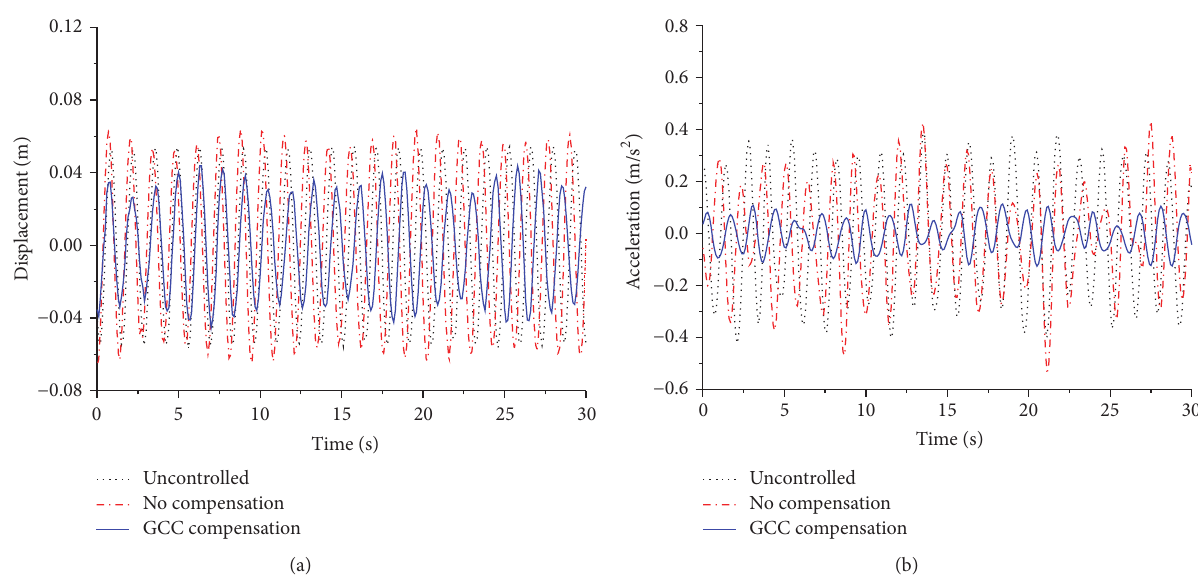
Figure 11: Comparison of structural responses to 4th floor of the experimental system under uncontrolled and controlled without compen- sation and with GCC compensation. (a) Displacement. (b)